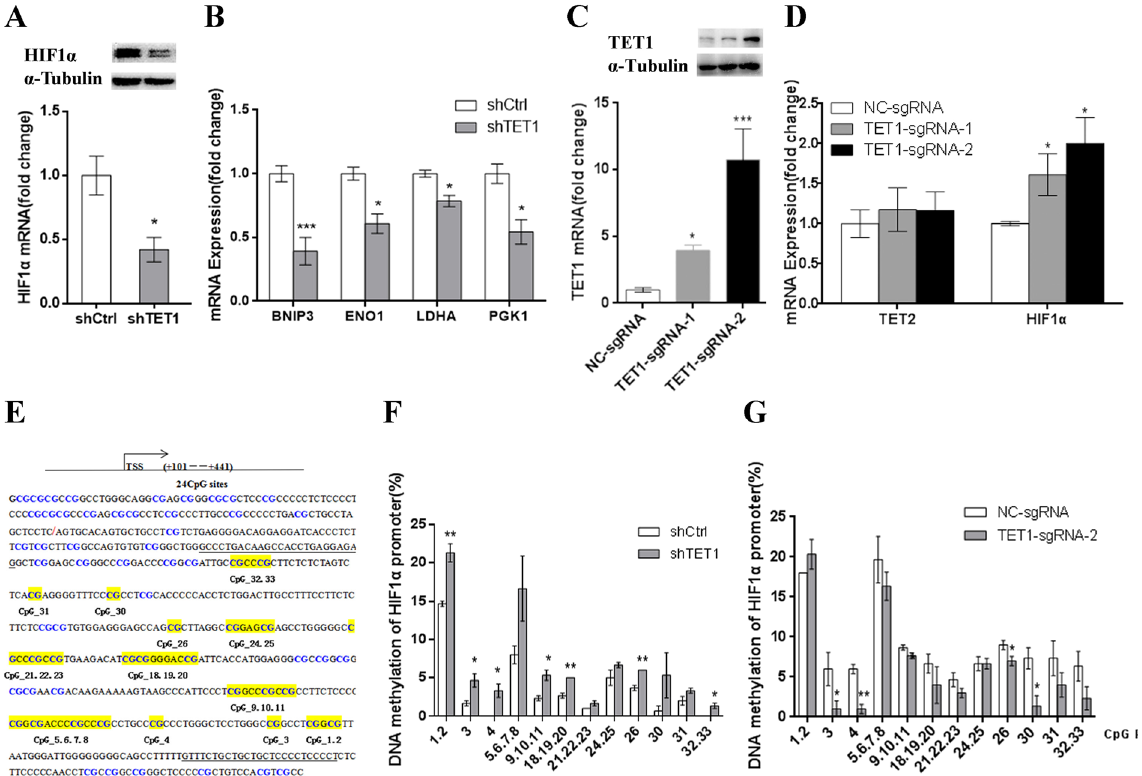
Figure-5. TET1 regulates the expression of HIF1 α following exposure to 3% O 2 , which is accompanied by changes in the hyper- or hypo-methylation status of the HIF1 α promoter. ( A ) The mRNA and protein expression of HIF1 α in TET1 knockdown JEG3 cells exposed to 3% O 2 for 48 h. ( B ) After TET1 knockdown in JEG3 cells exposed to 3% O 2 for 48 h, the mRNA expression of the HIF1A α target genes BNIP3, ENO1, LDHA and PGK1 was altered. ( C ) qPCR and western blotting analyses showing the overexpression efficiency of TET1 in JEG3 cells transected with sgRNAs. ( D ) The mRNA expression of TET2 and HIF1 α in TET1-overexpressing JEG3 cells exposed to 3% O 2 for 48 h. ( E ) The HIF1 α promoter region. The blue color indicates the CpG sites. The 24 CpG sites shaded in yellow were divided into 12 units for the analysis. TSS is labeled by the red oblique line. The primer region is underlined. ( F , G ) DNA methylation of the HIF1 α promoter at different CpG units was detected in JEG3 cells cultured in 3% O 2 for 48 h using MALDI TOF mass spectrometry. ( * P < 0.05, ** P < 0.01, Student’s